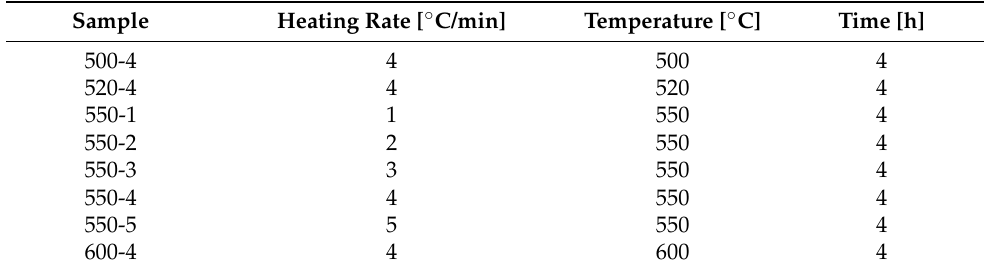
Table 6. Preparation conditions of polymeric carbon